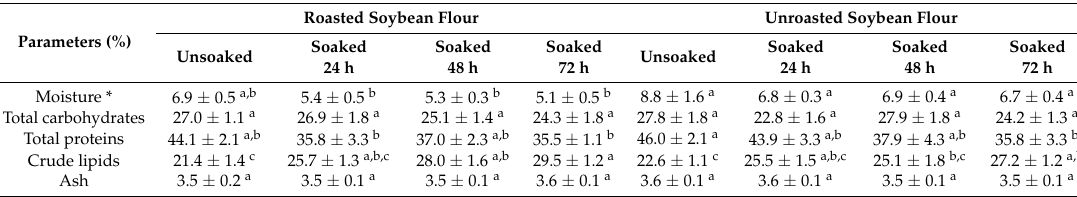
Table 1. Proximate composition (expressed in g/100 g dry weight basis) of soybean flour as affected by roasting and soaking